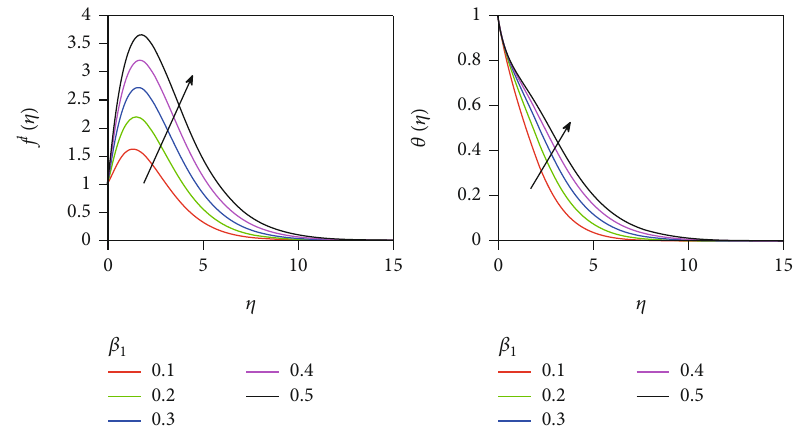
Figure 14: Signi fi cance of the thermal fl ux relaxation parameter on velocity and temperature plots.